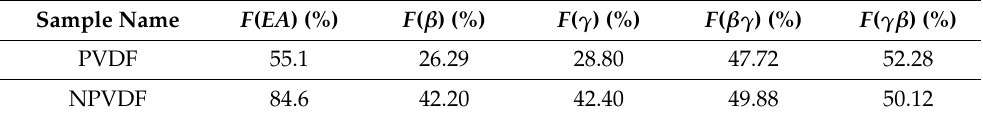
Table 3. Individual polar phase contents in the fabricated composite films.